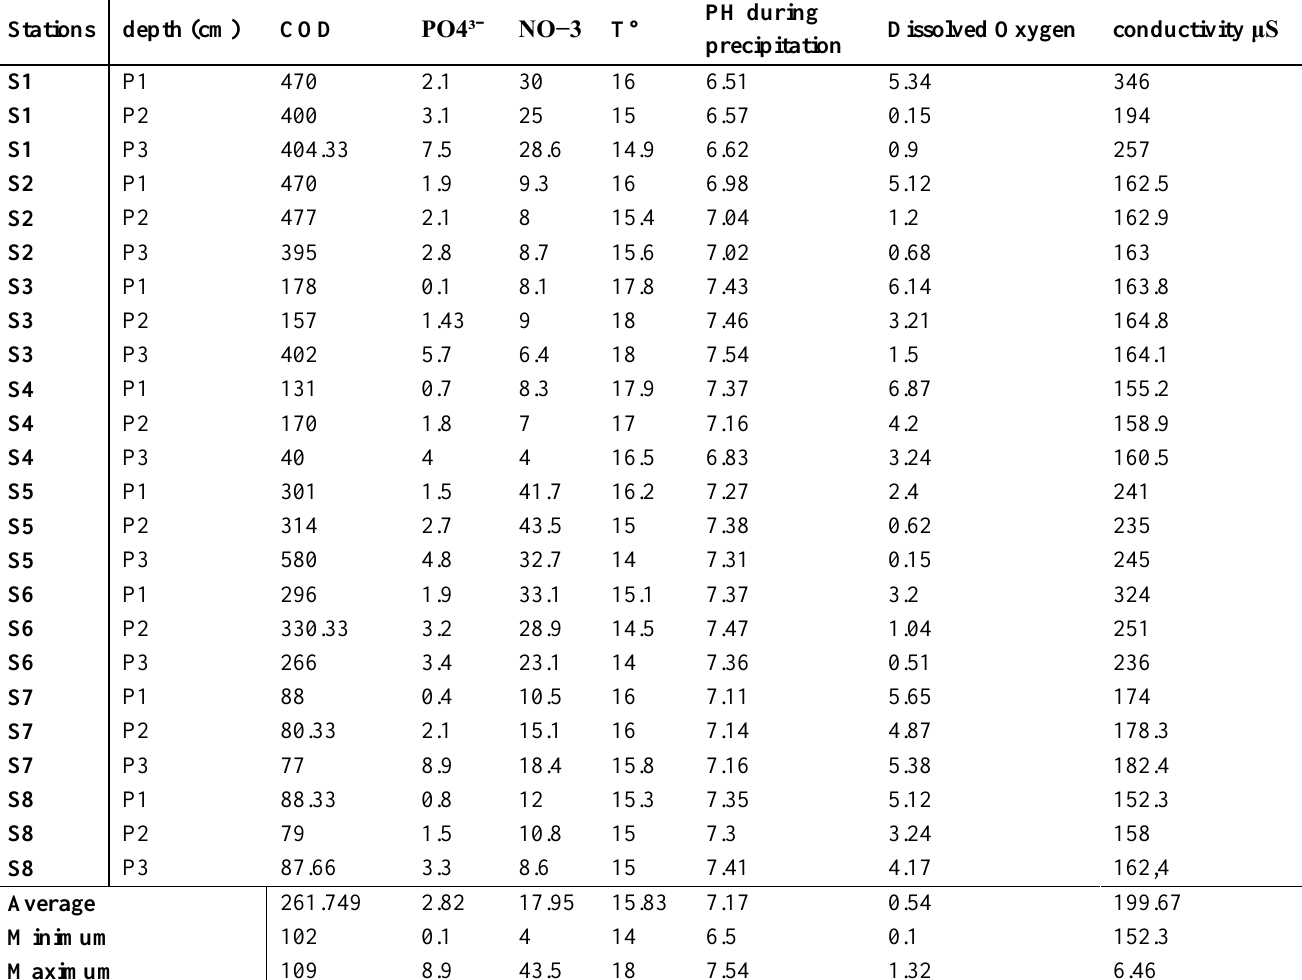
Table 3. Descriptive statistics of ten variables measured in the waters of eight sites of Lake Réghaia.